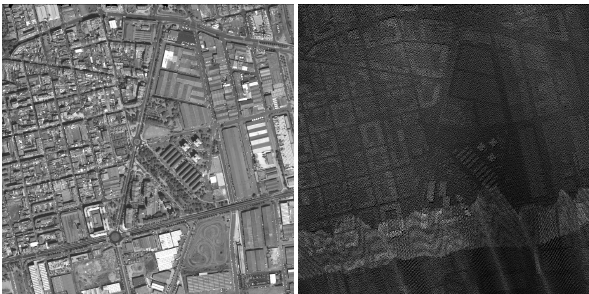
Figure 13: Detail of Terrassa testsite 1 km × 1 km, left ortho image, right reference laser DSM points